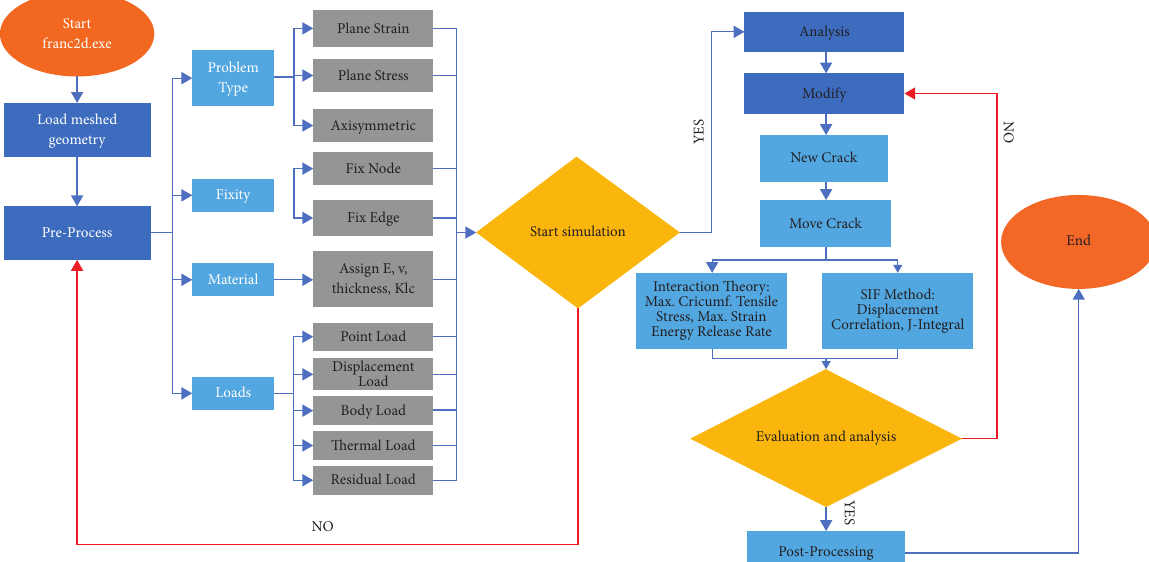
Figure 2: FRANC2D/L procedure for crack growth.